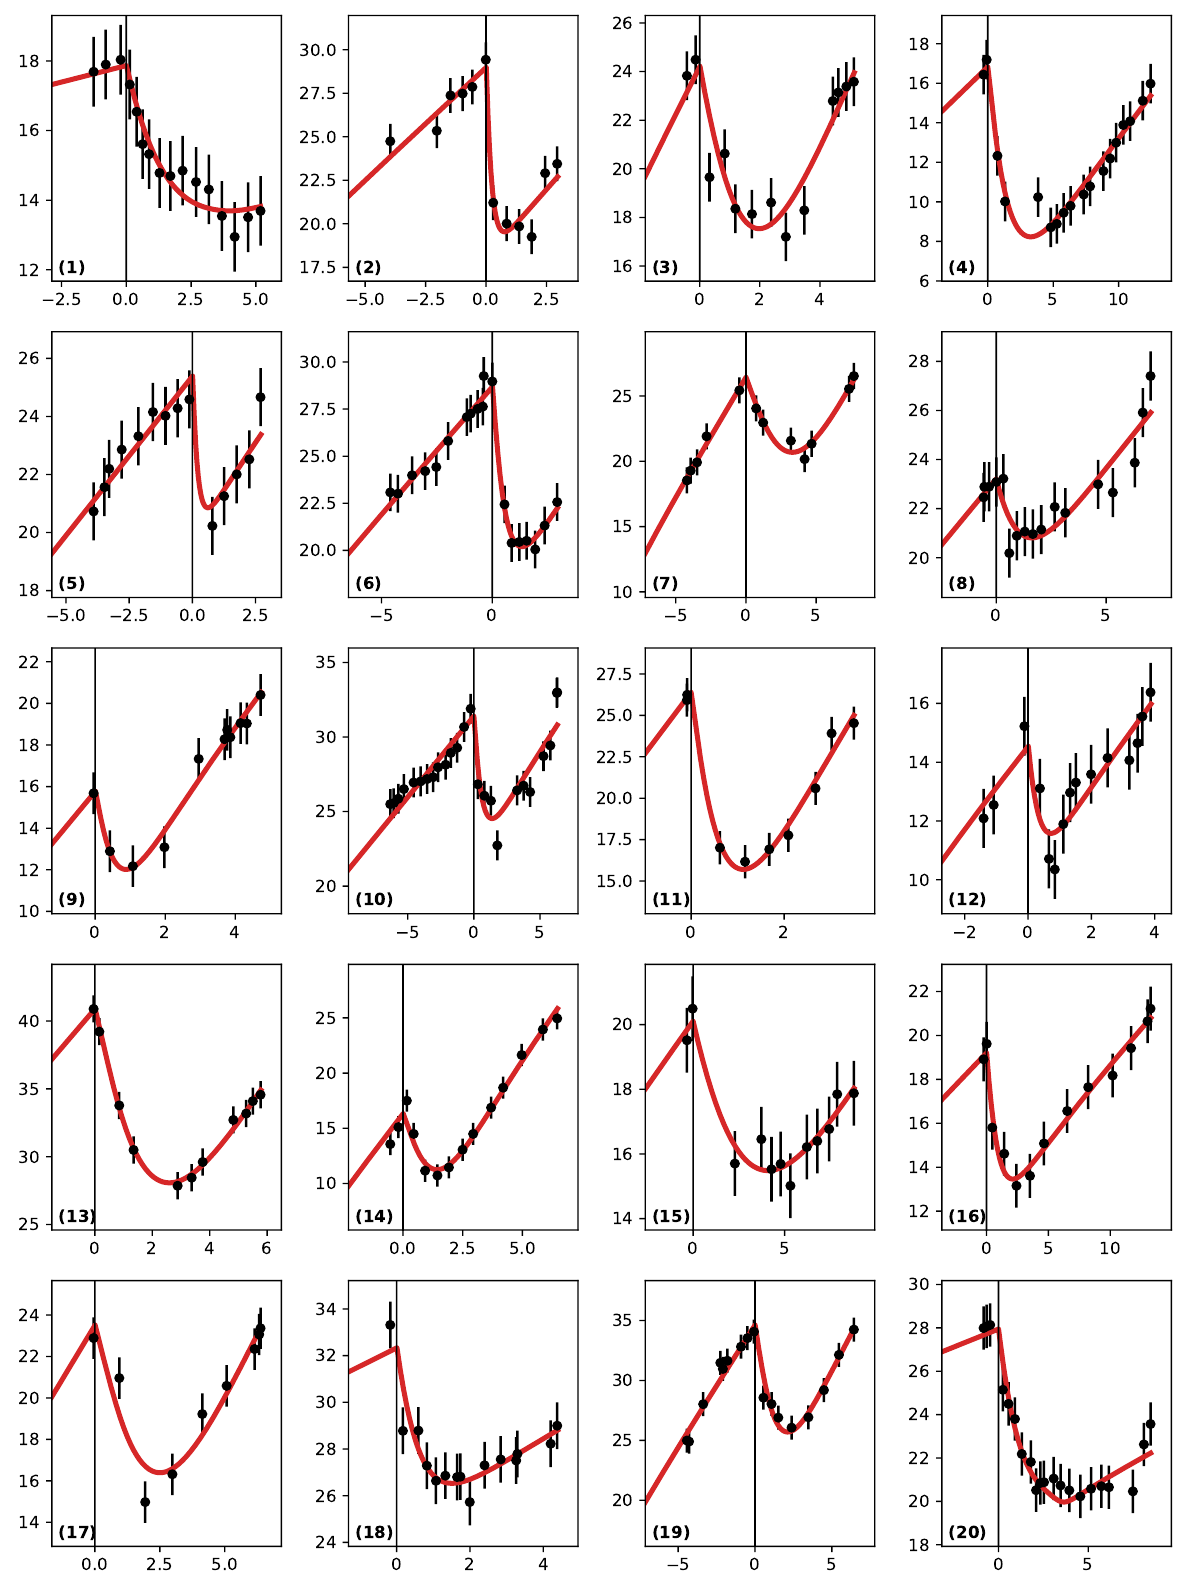
Figure 2. Comparison between the data points (in black) and our best fit models (red curve) for 20 patients. The abscissa represent time in years (with the origin at RT) and the ordinate of the tumor radius (in mm). Note that the scales are floating and span various ranges. The error bars on the measurements are 1